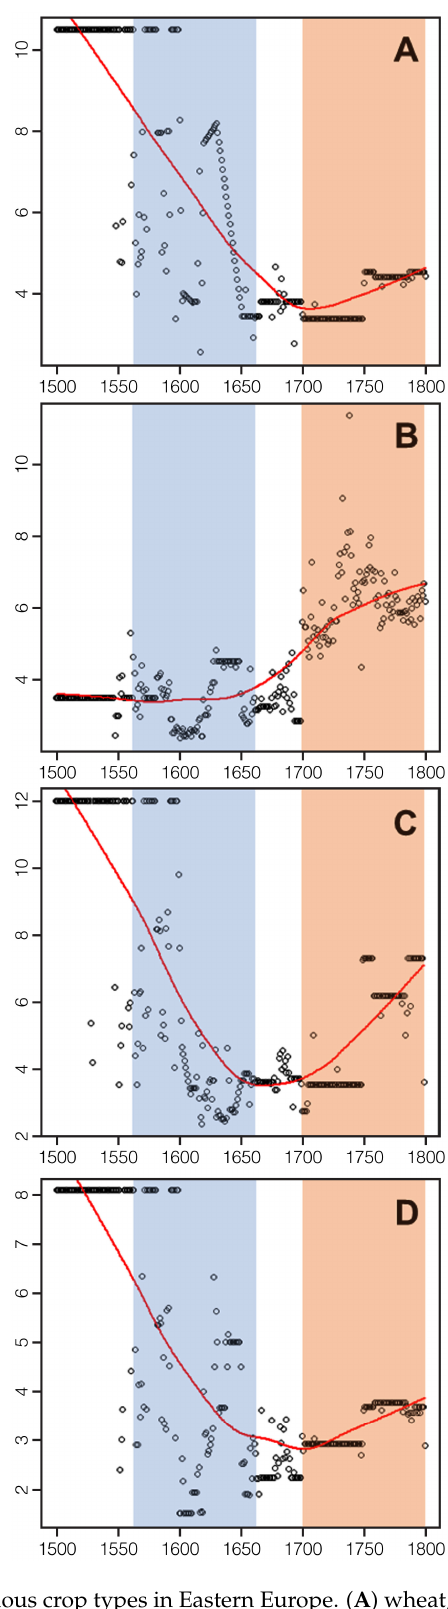
Figure 4. Yield ratio of various crop types in Eastern Europe. ( A ) wheat; ( B ) rye; ( C ) barley; ( D ) oats. Note: Scatter plots in the figure are the raw data of crop yield ratio. Red line represents the general trend of crop yield ratio that is derived from non-parametric analysis. Blue shade indicates the extreme cooling period during the Little Ice Age (AD 1560–1660), while red shade indicates the warm agricultural recovery period (AD 1700–1800).